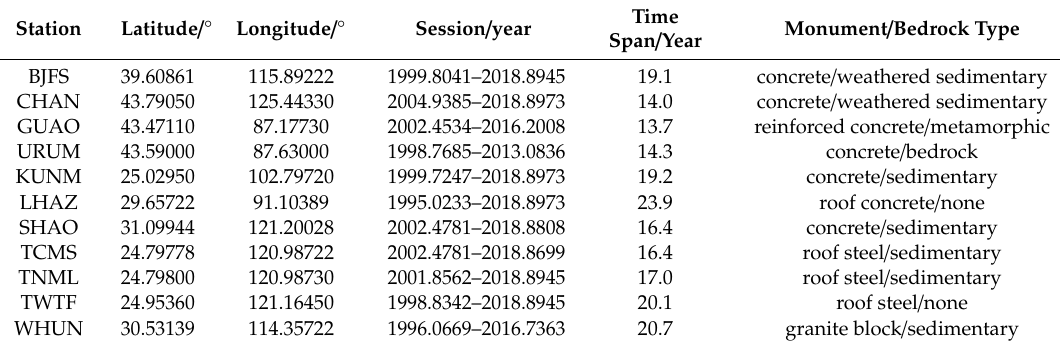
Table 1. Introduction of the original coordinate time series of IGS stations in China.